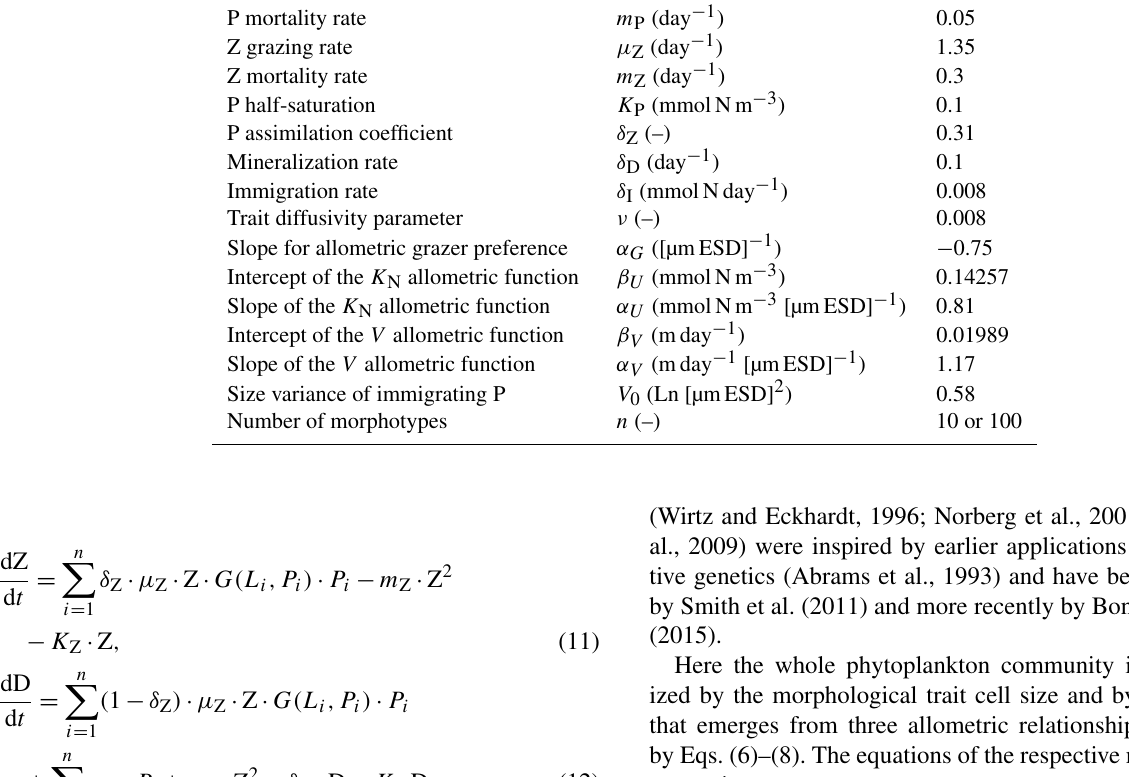
Table 1. Parameter definitions, their units, and their default values as provided in PhytoSFDM. Definition Symbol (units) Value Diffusive mixing across the thermocline κ (mday − 1 ) 0.1 Light attenuation constant Optimum irradiance P mortality